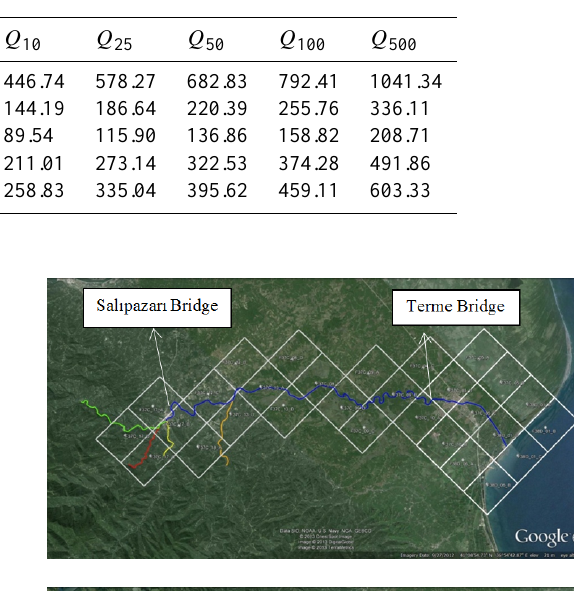
Table 1. The peak values of the hydrographs having different return period for four subbasins and the area of the sub basins.